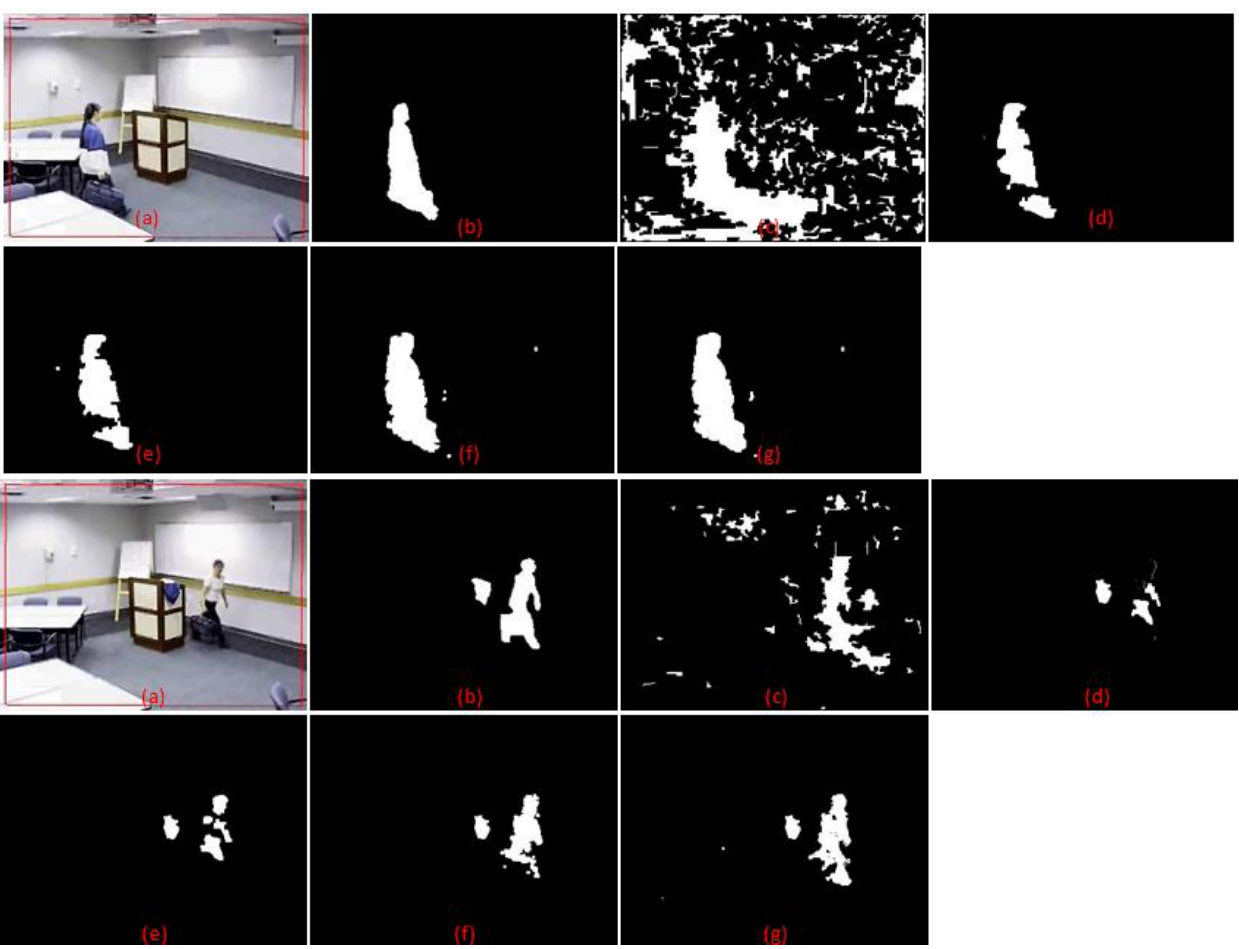
Figure 9. Simulation results: ( a ) Input ( b ) Ground truth ( c ) MoG ( d ) Method: Li et al.